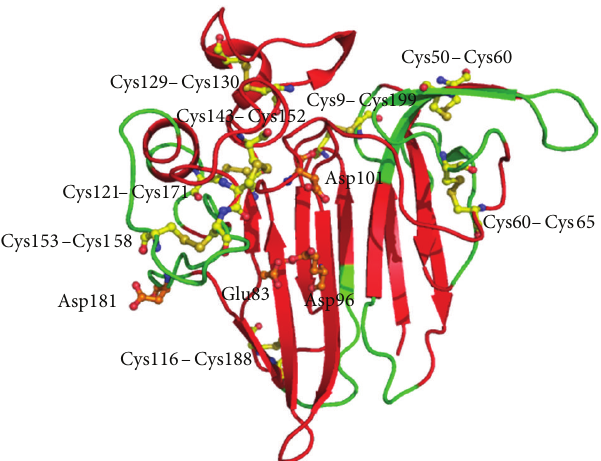
Figure 8: Three-dimensional structure of Banana TLP. Eight disul- phide bridges and the acidic residues, Glu 83, Asp96, Asp101, and Asp111 are shown. Twelve amino acid stretches are marked in